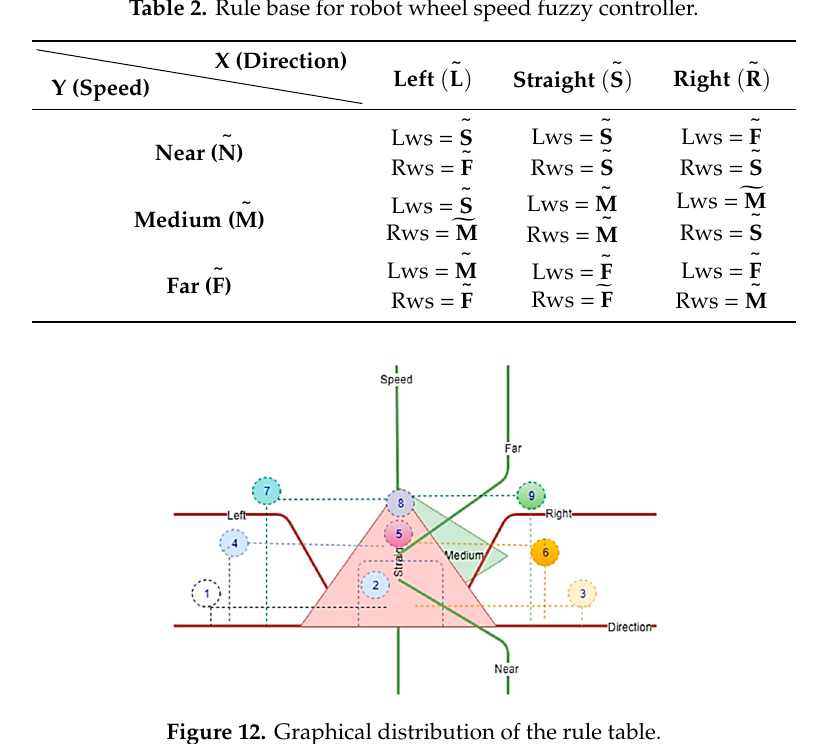
Table 2. Rule base for robot wheel speed fuzzy controller.